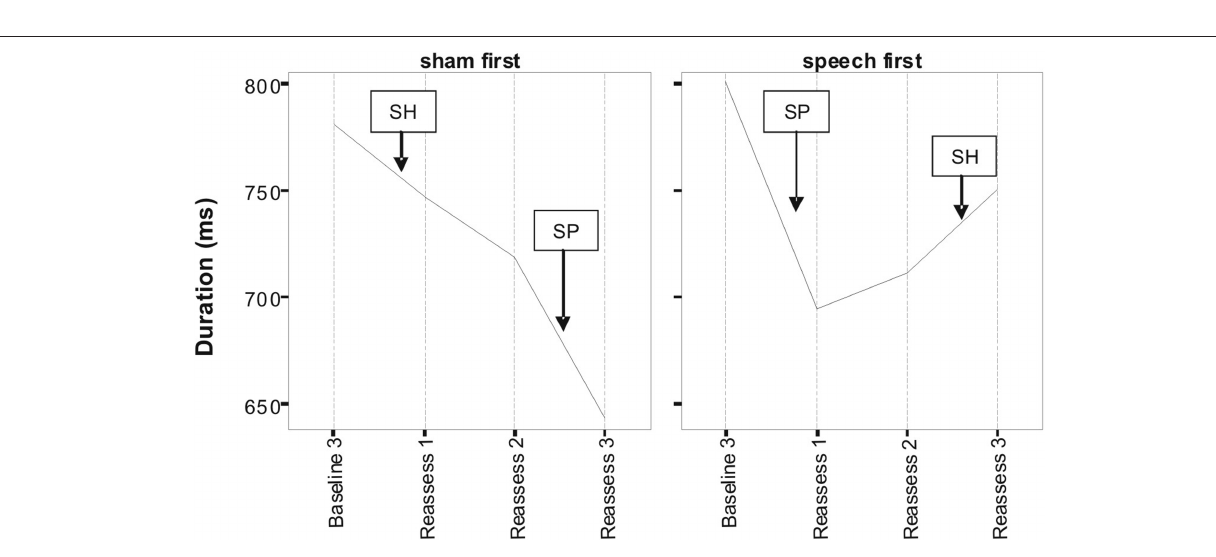
FiguRE 3 | Lexical duration scores as a function of speech treatment (SP) and sham treatment (SH) for the two phase conditions defined as Sham First and Speech First. Due to missing values at some assessment points, only data points used in delta score computations are depicted here (see text for